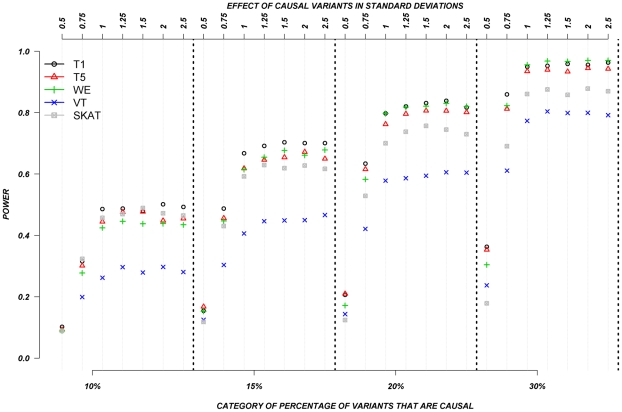
Dichotomous traits: Relationship between effect size, proportion of causal variants, and power, when causal variants only have a deleterious effect.Each box corresponds to a different proportion of causal variants involved in the relationship between rare variants and continuous traits (from left to right, 10, 15, 20 and 30%). On the x-axis, effect sizes are in standard deviations and correspond to the absolute value of the average size effect.